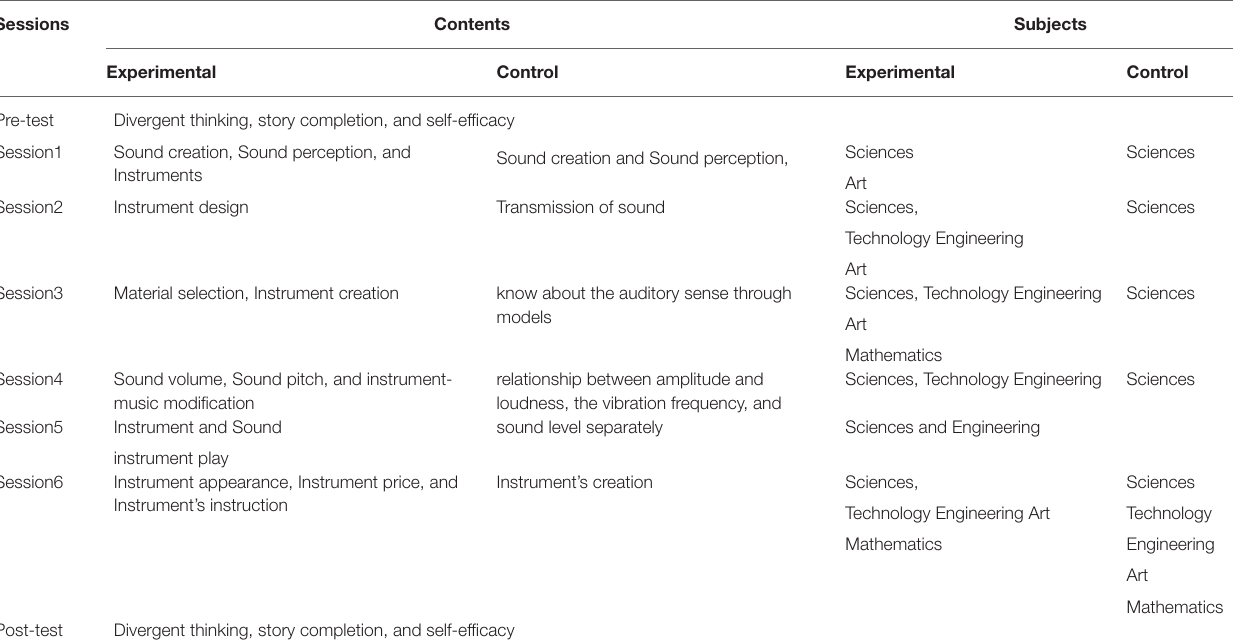
TABLE 1 | Main contents of sessions in the experimental group and the control